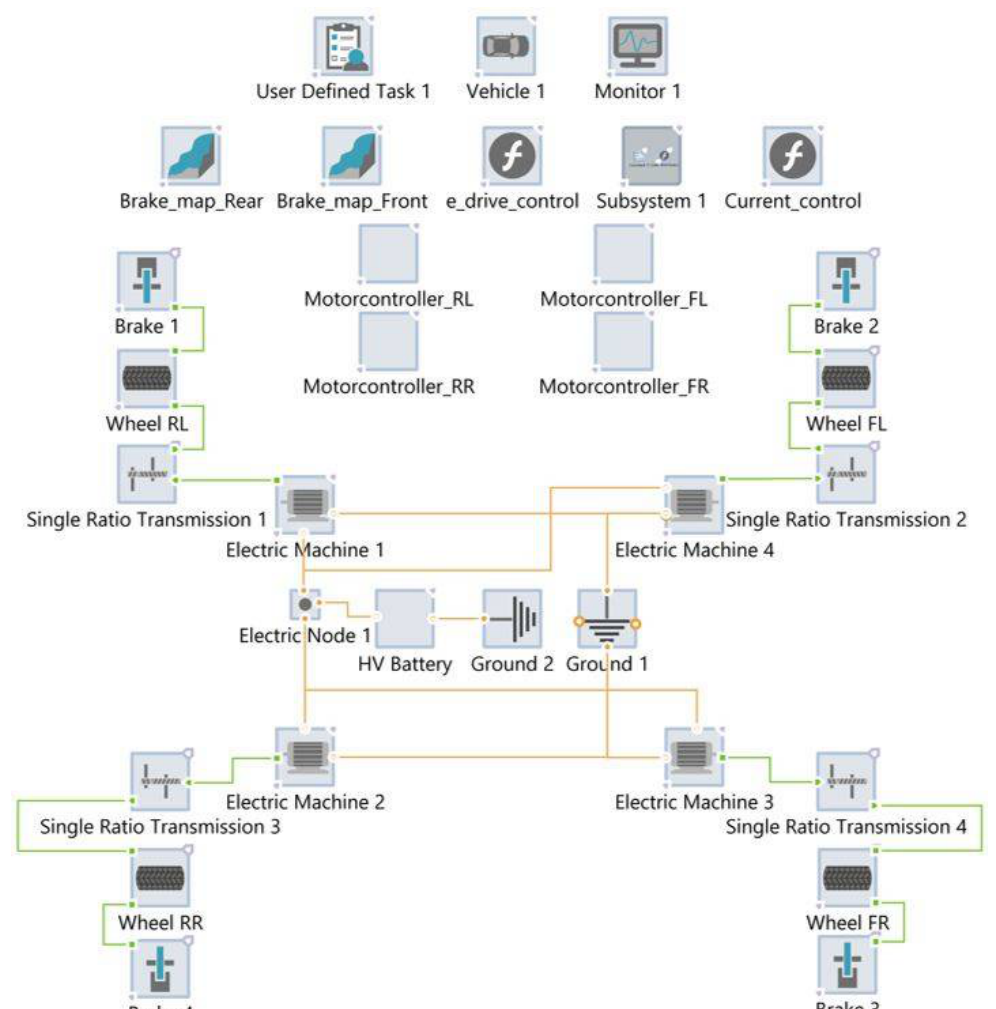
Figure 4. Initial model of the drive-train in the simulation environment.